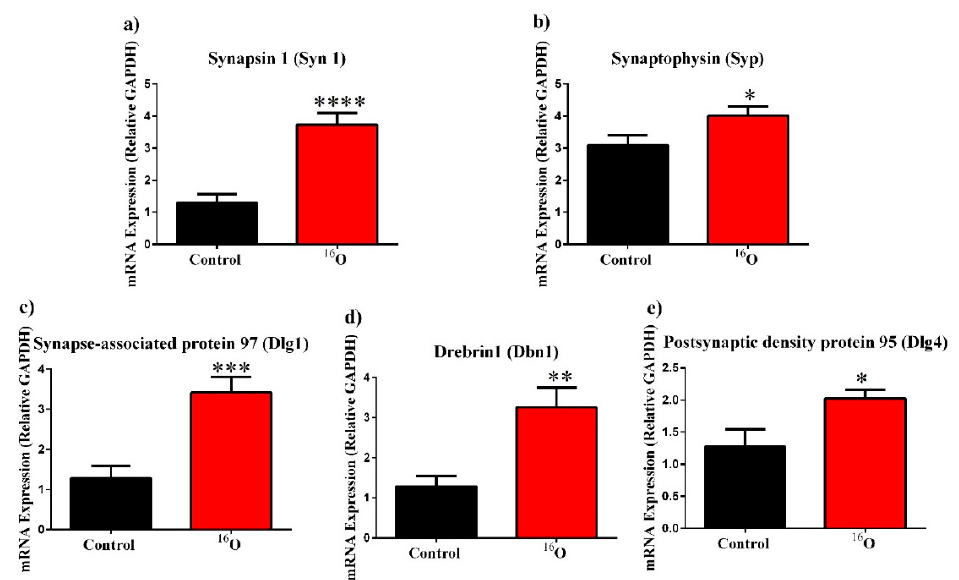
Figure 7. Alterations in synaptic marker mRNA expression. 16 O significantly up-regulates expression of ( a , b ) Presynaptic vesicle trafficking marker Synapsin 1 and marker of synaptic density Synaptophysin. ( c – e ) Postsynaptic density markers Synapse associated protein 97, Drebrin 1 and Postsynaptic density protein 95 were up-regulated by radiation Average ± SEM ( n = 10); * p < 0.05, ** p < 0.01, *** p < 0.001, **** p <